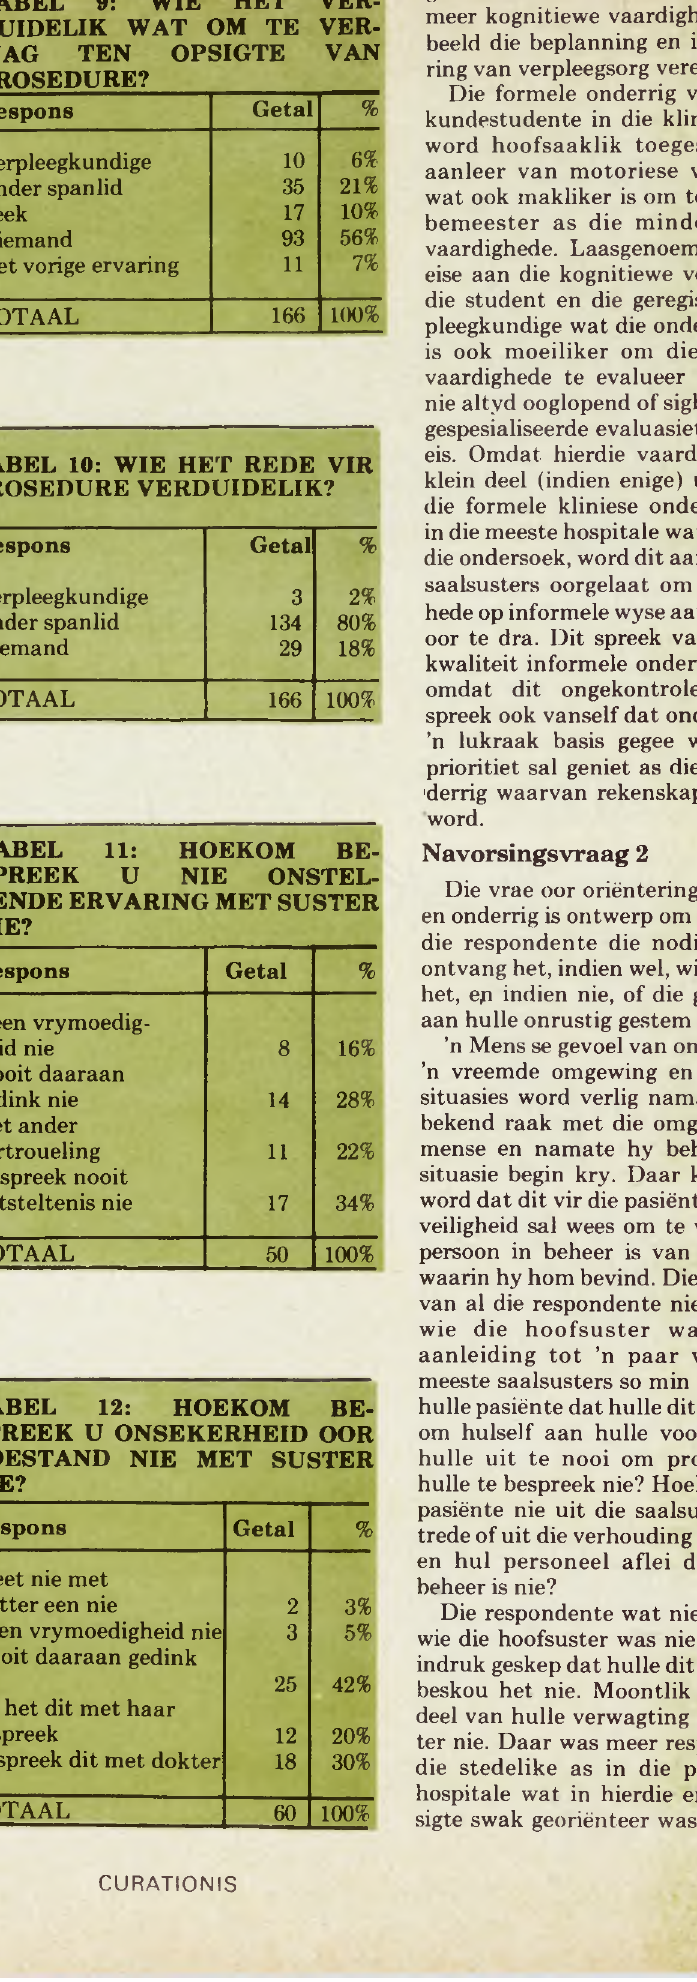
TABEL 10: WIE HET REDE VIR PROSEDURE